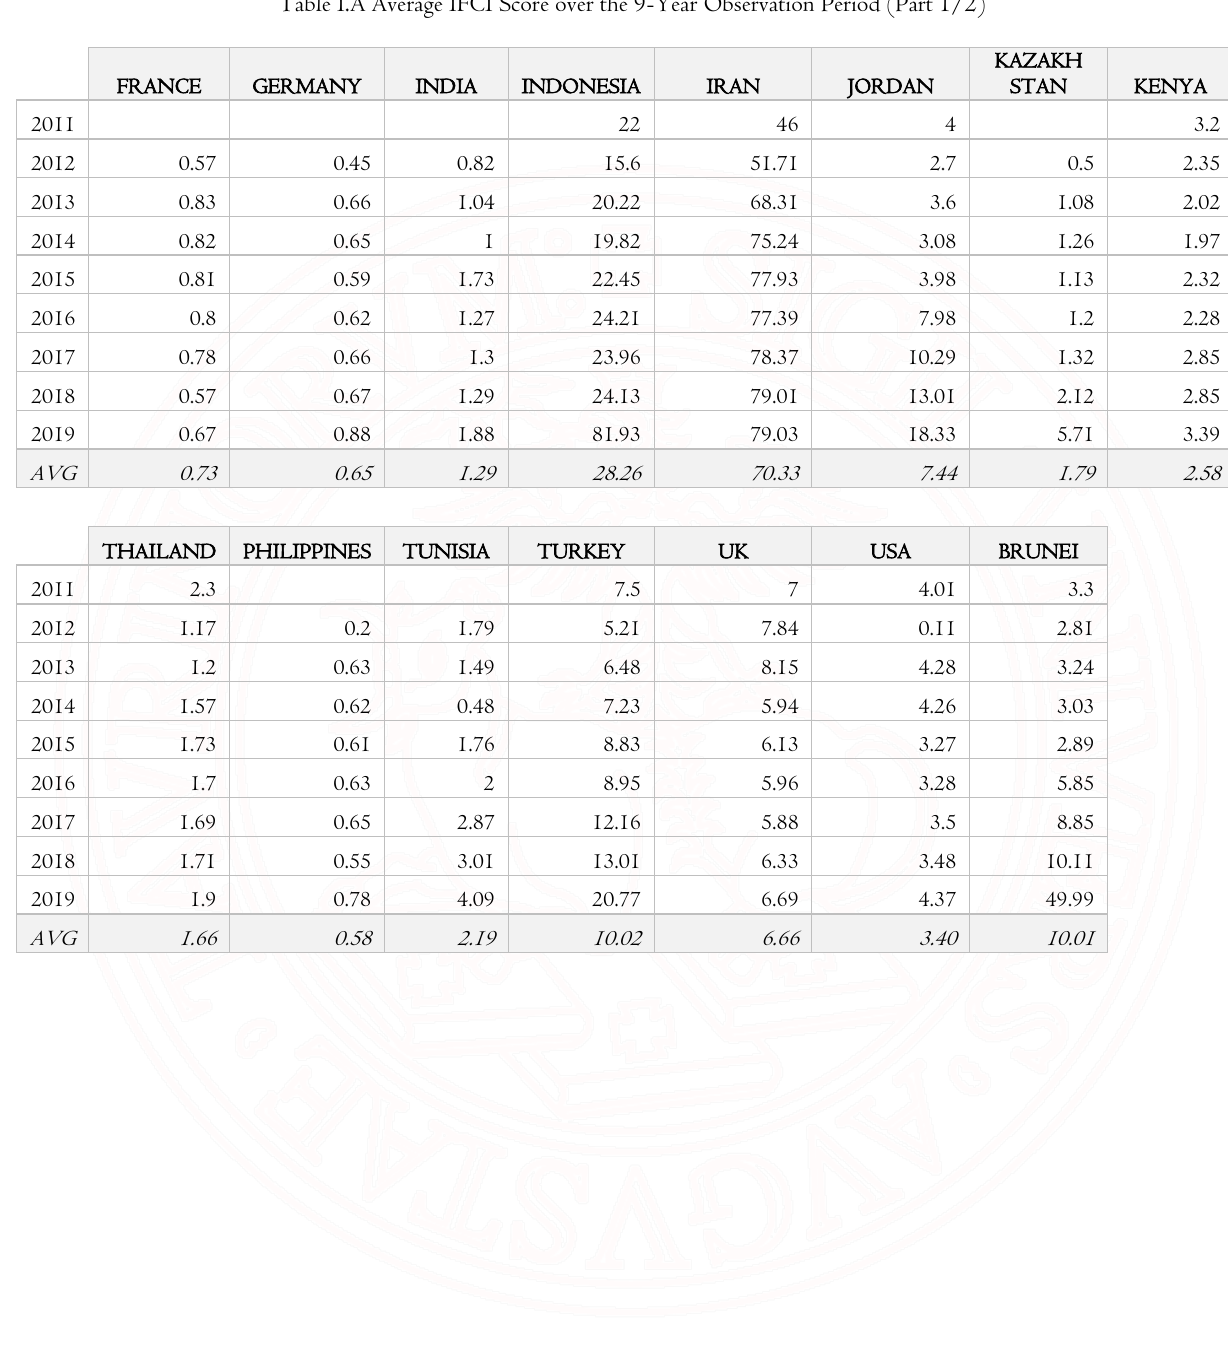
Table I.A Average IFCI Score over the 9-Year Observation Period (Part